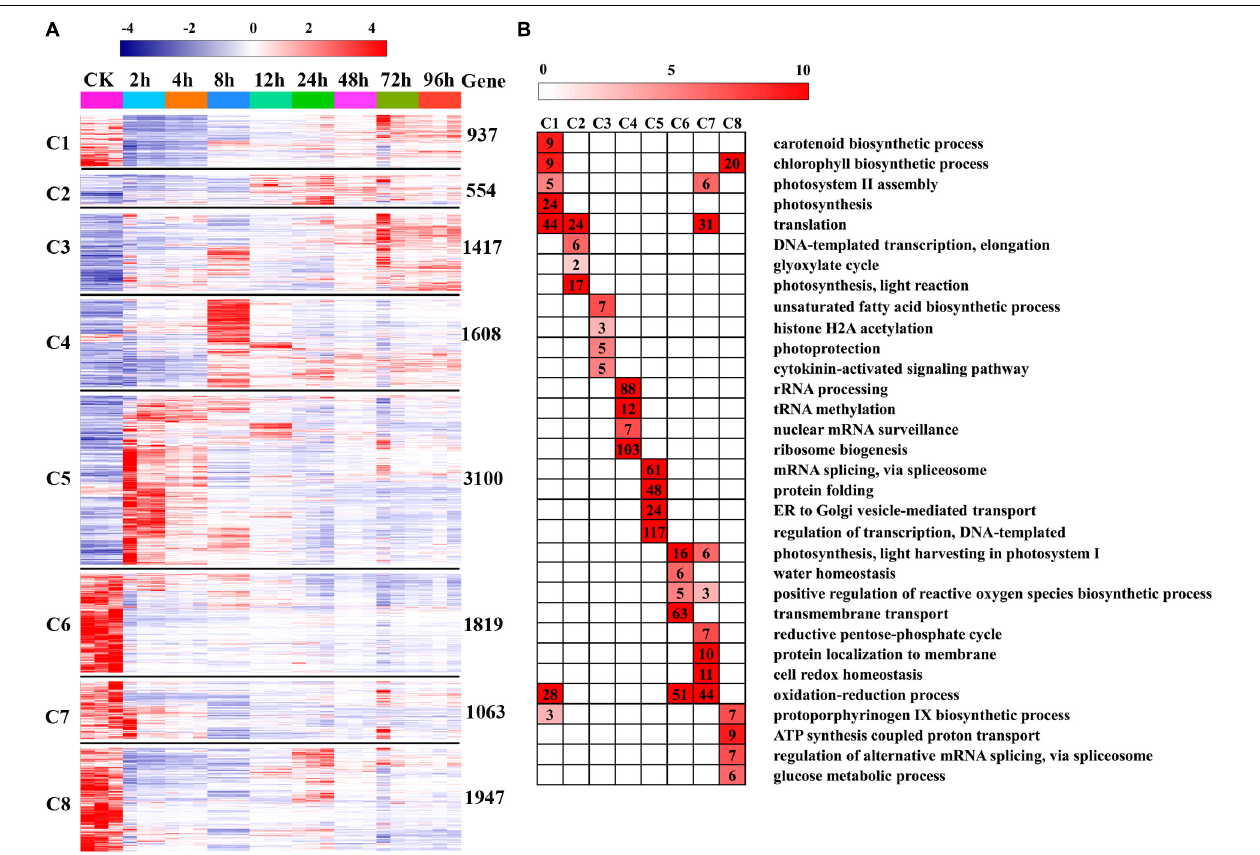
FIGURE 3 | Gene expression pattern and functional transition over the time course. (A) Expression patterns of 12,445 differentially expressed genes (DEGs) genes in eight DEGs clusters. The number of genes in each cluster is shown on the right. (B) Gene Ontology (GO) enriched in eight DEGs clusters. Top four/five significant categories ( P -value < 0.05) are